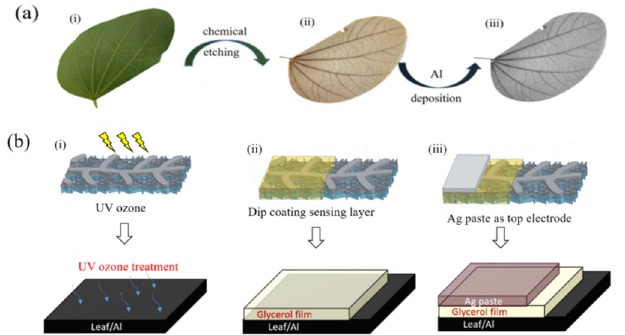
Figure 1. ( a )(i–iii) Chemical etching and metal deposition process of leaf vein-based metal grid substrates. ( b )(i–iii) A schematic illustration of the fabricated leaf vein-based humidity sensor.